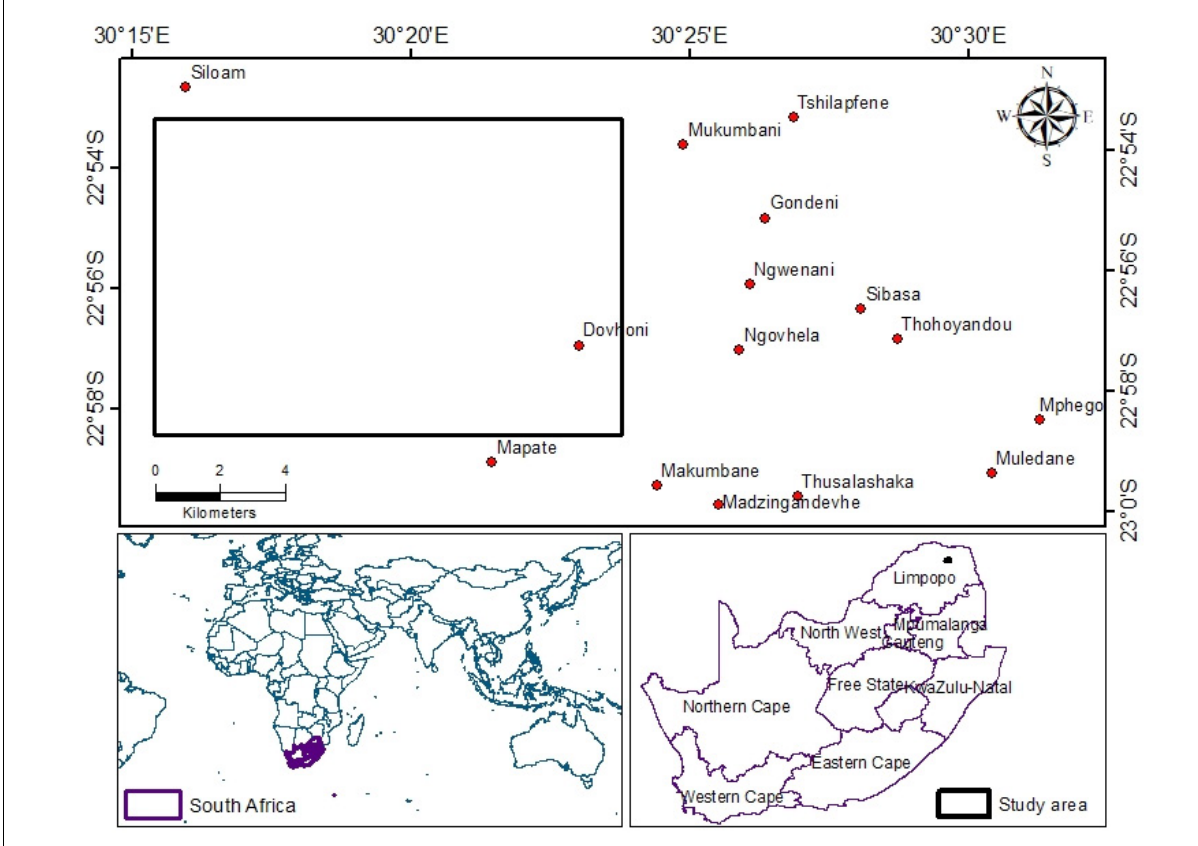
Figure 2: Locality map of the study